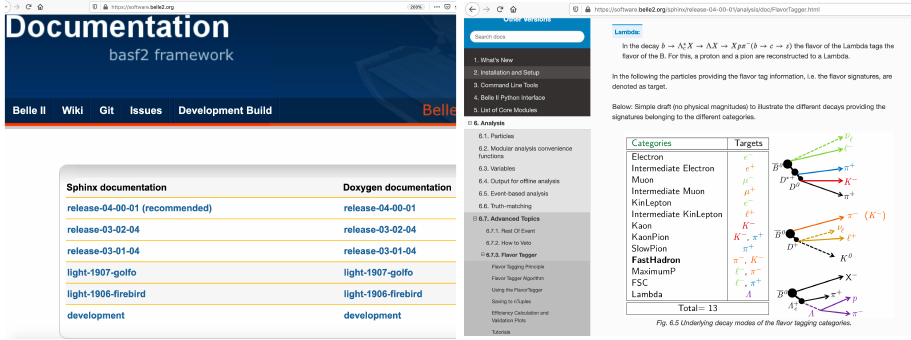
Figure 1. Landing page of the documentation server with choise of the release (left) and screenshot of the user documentation renderred by Sphinx